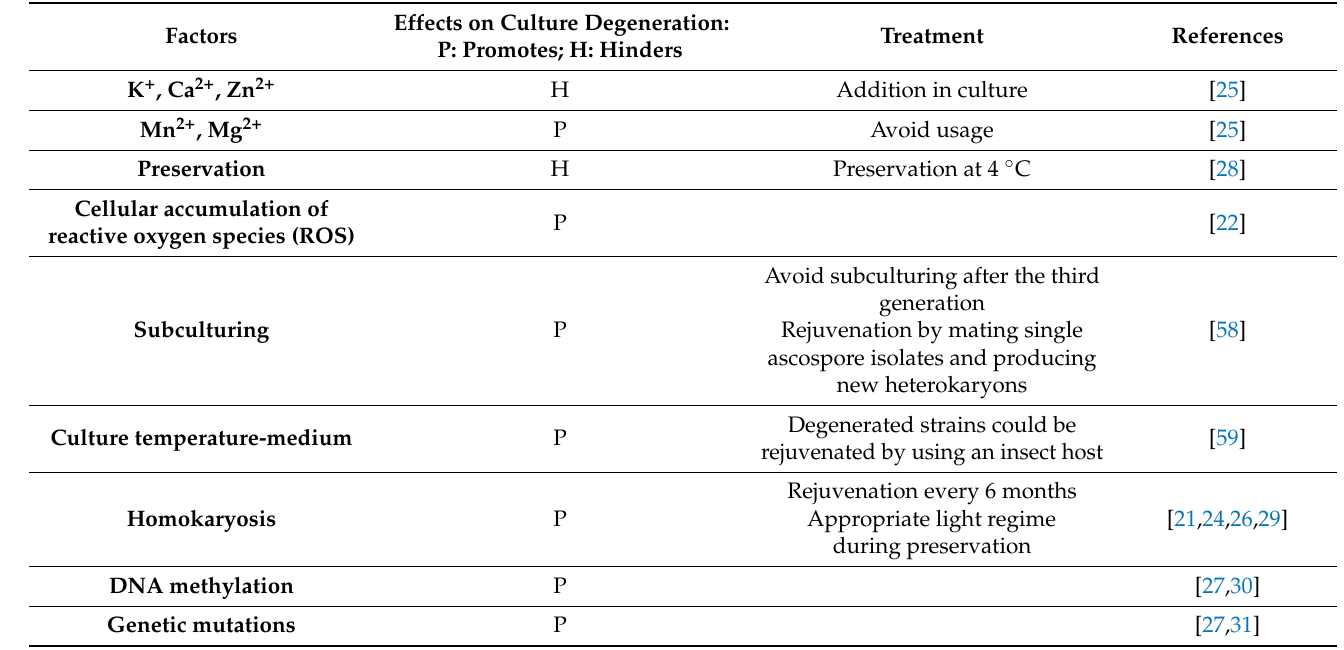
Table 1. Factors that affect culture degeneration in C. militaris , their effect, and potential treatment. Effects on Culture Degeneration: Factors P: Promotes; H: Hinders